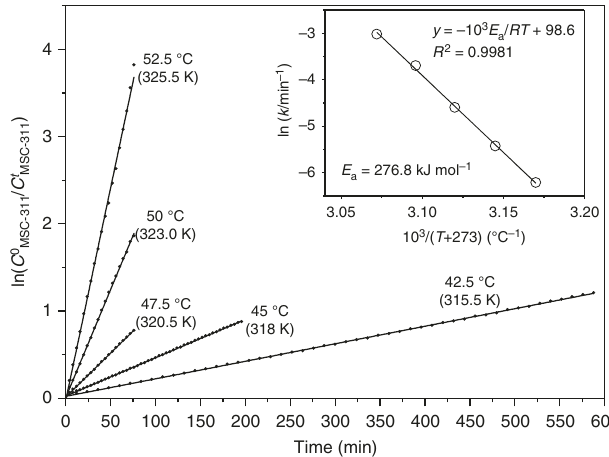
Fig. 5 First-order reaction kinetics fi tting for the MSC-311 ⇒ MSC-322 transformations. Five identical MSC-311 dispersions in toluene (3 mL) were made from a single MSC-311 sample (~20 mg). The fi ve dispersions were placed at the fi ve temperatures ( T ) as indicated from 42.5 to 52.5 °C. The (cid:4) (cid:5) = C t time-dependent quantity ln C 0 (solid circles) fi ts well with MSC (cid:1) 311 MSC (cid:1) 311 fi rst-order reaction Eq. (3) (solid lines). C 0 represents the starting MSC (cid:1) 311 concentration of MSC-311 and C t is the time-dependent MSC (cid:1) 311 concentration of MSC-311 during the transformation. The slopes of the fi tted lines correspond to the rate constants k (min − 1 ). The inset shows the Arrhenius plot, with a y -axis of ln( k ) and an x -axis of 1/ T . The slope of the fi tted line is E R , where E R the ideal gas constant a / a is the barrier energy and